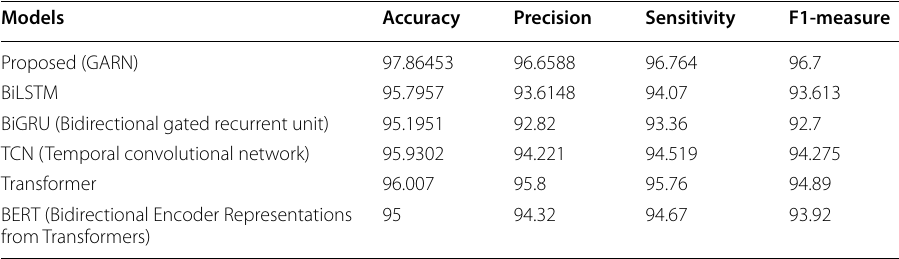
Table 8 Performance between proposed and existing methods for developed objective Models